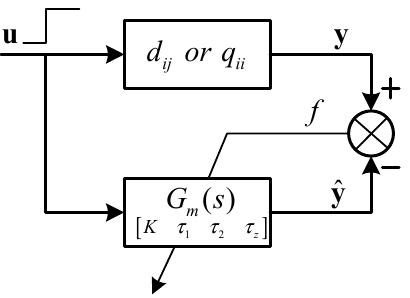
Figure 3. Structure of the approximation algorithm.